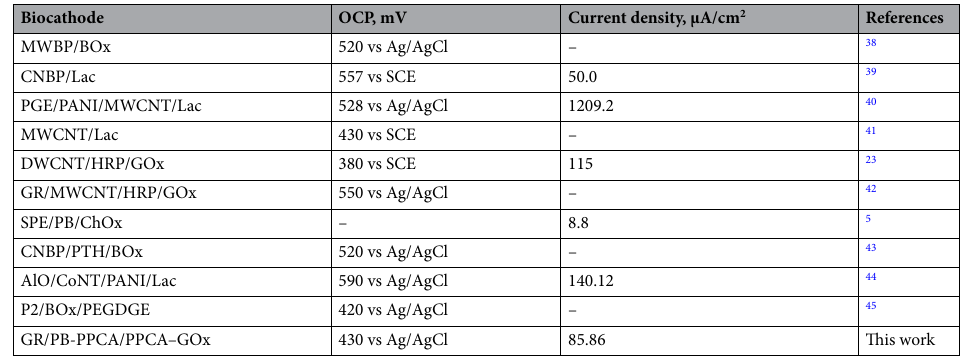
Table 2. Comparison of the performance of some biocathodes described in the literature with the biocathode developed in this work. MWBP - multi-walled carbon nanotube paper; BOx - bilirubin oxidase; CNBP - carbon nanotube buckypaper; PGE - pencil graphite electrode; MWCNT - multi-walled carbon nano tubes; MWCNT - double-walled carbon nano tubes; HRP - horseradish peroxidase; SPE - screen-printed electrode; ChOx - cholesterol oxidase; PTH - polythiophene; AlO - anodic aluminium oxide template; CoNT - copper nanotubes; PEGDGE - poly(ethylene glycol) diglycidyl ether; P2 - poly(1-vinylimidazole-co-[2- (methacryloyloxy)ethyl]trimethylammoniumchloride)-[Os(bpy) 2 Cl] +